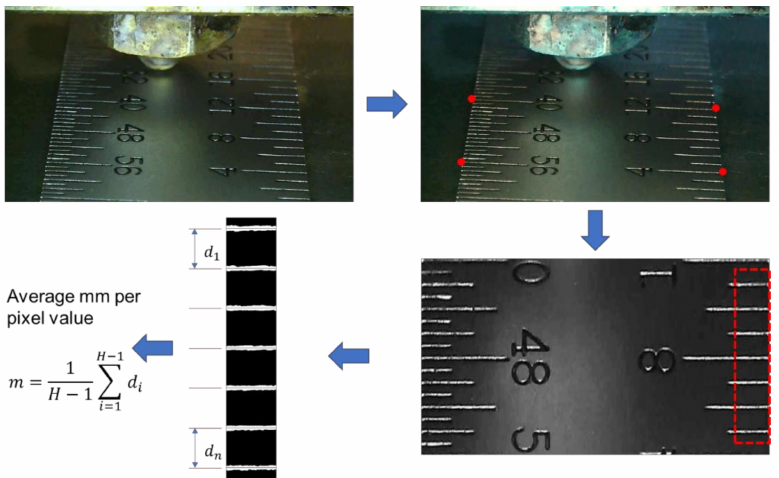
Figure 7. Sequence of steps in mm-per-pixel calibration procedure starting from top left, original image, 4-point selection, perspective corrected image, binary image of scale graduations (H = total number of hatch marks in the